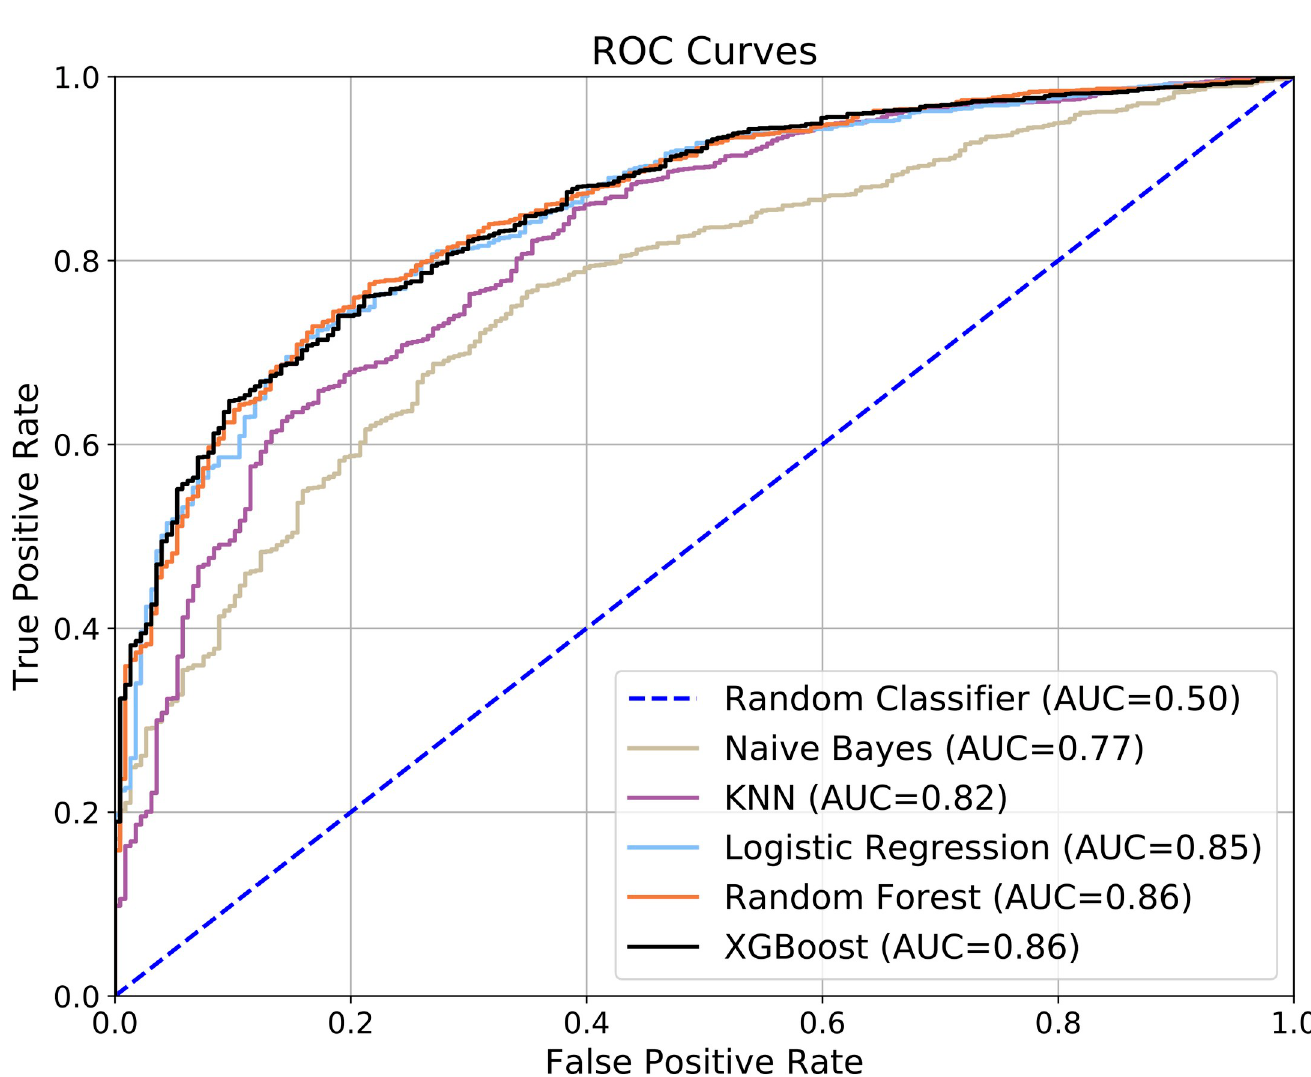
Fig 5. ROC curves. The curves correspond to the validation fold that yielded the median ANSA.